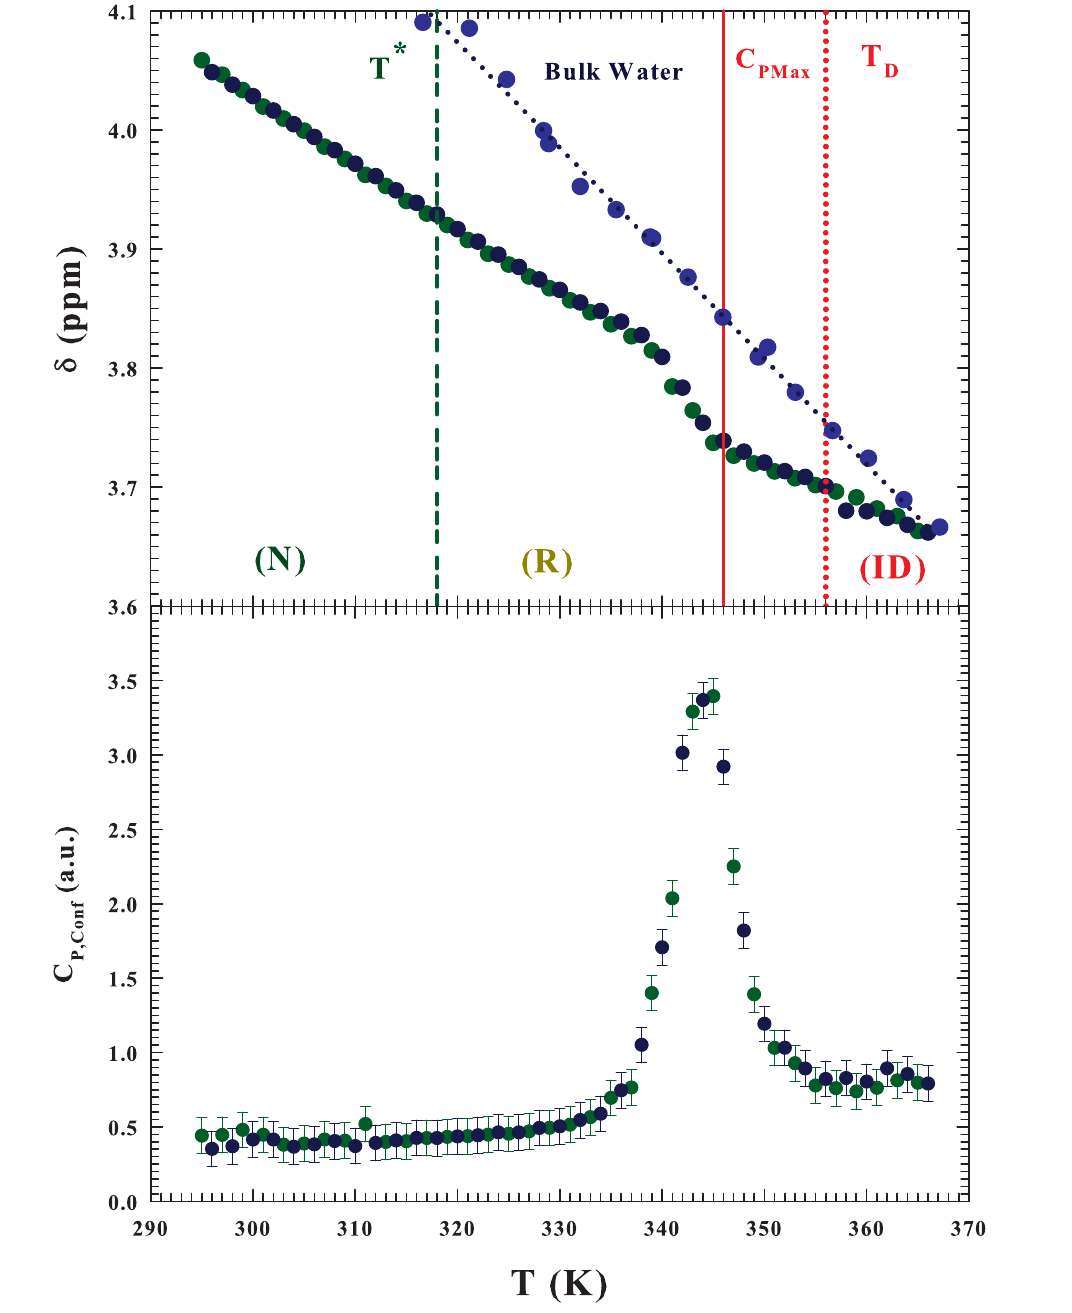
Figure 6. Top panel: the thermal evolution, in the range 295–368 K, of the measured 1 H NMR chemical shift δ ( T ) during the temperature induced protein unfolding of the hydrated lysozyme at h = 0.3, along with that of pure water. Instead the bottom of the figure proposes the corresponding configurational specific evaluated, by considering that the chemical shift is a measure of the atomic local order, as: C P , conf = − T ( ∂δ ( T ) / ∂ T ) P